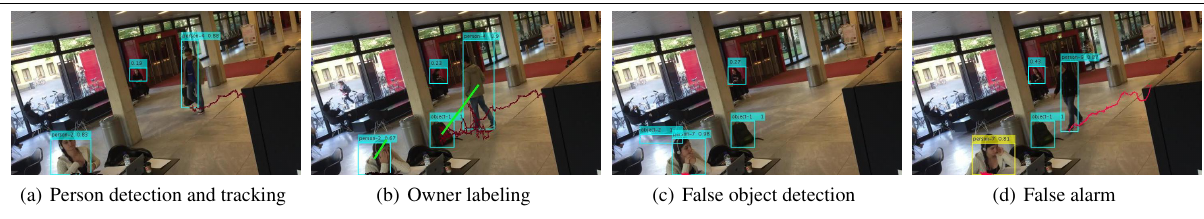
Figure 7: An example of experimental results on SERD. A man comes into the room (a). Then he left his bag on the table and begins to work(b). He is labeled as the owner but the bag is not labeled as abandoned object. Another man left his before the white board (c) and left the scene (d). He is labeled as the owner and the bag is labeled as abandoned object. The owner takes his bag away without alarm (e). He switches the bag by his (f), and a warning is issued that the bag does not belongs to him and he is labeled as the owner of the substitute objects (g). He is recognized as a theft when he is leaving (h).